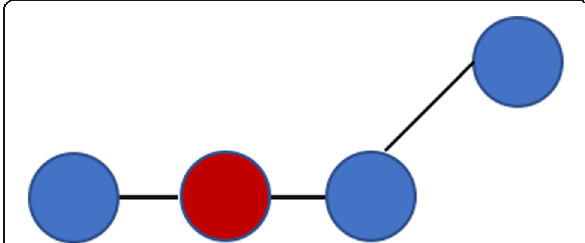
Fig. 1 Example network consisting of four actors. The middle actor is shaded red and has a tie to each blue actor on the